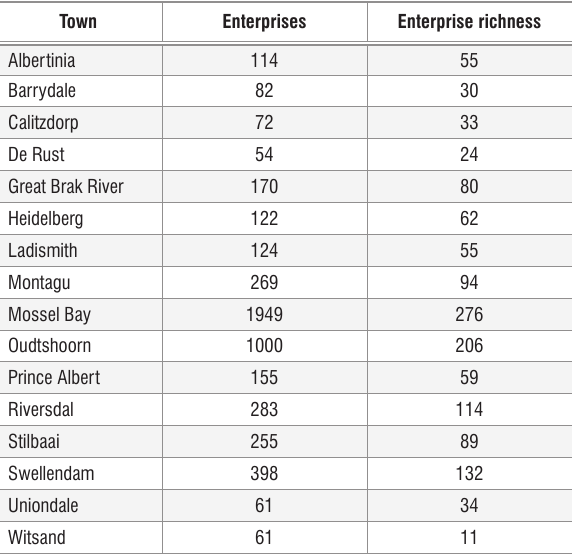
Total number of enterprises and enterprise types (enterprise richness) in Gouritz Cluster Biosphere Reserve towns in